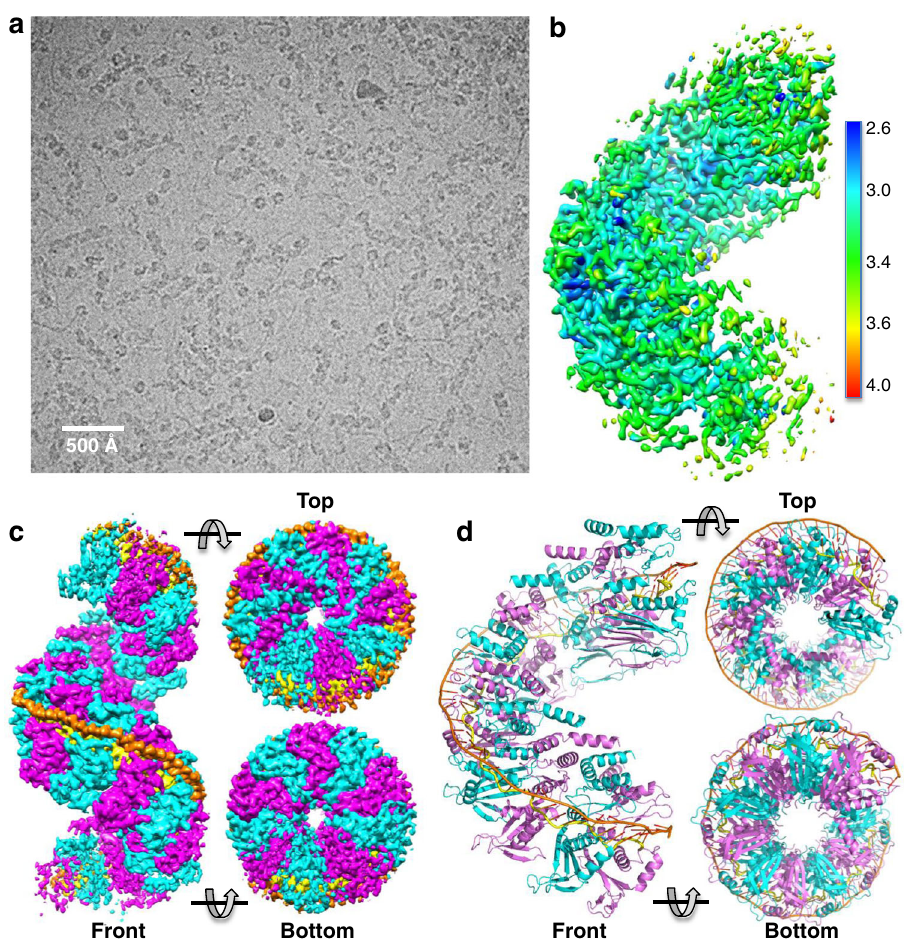
Fig. 1 | Cryo-EM structure of LiRecT bound to 83-mer annealed duplex. a Example cryo-EM image at 81,000×. The image is one of 2038 that gave similar results. b 3Dreconstructioncolored according to localresolution.The mapcovers the central 10 subunits of the fi lament. c Views of the full 18-subunit 3D